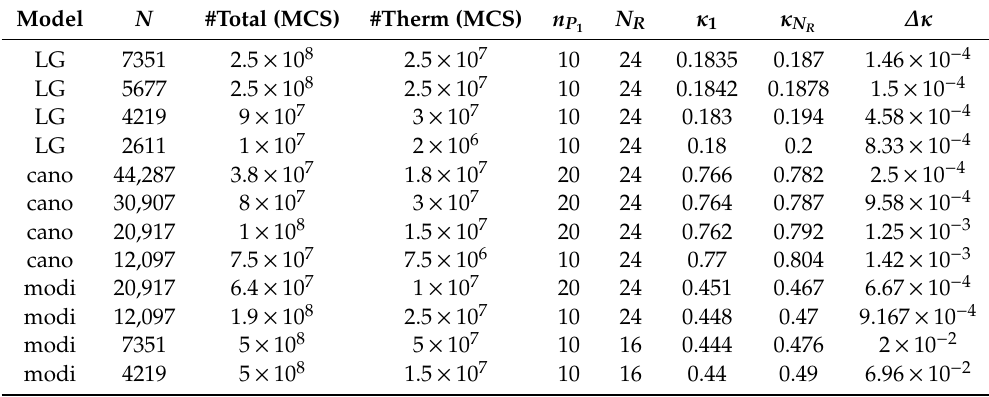
denotes the total number of MMC 1